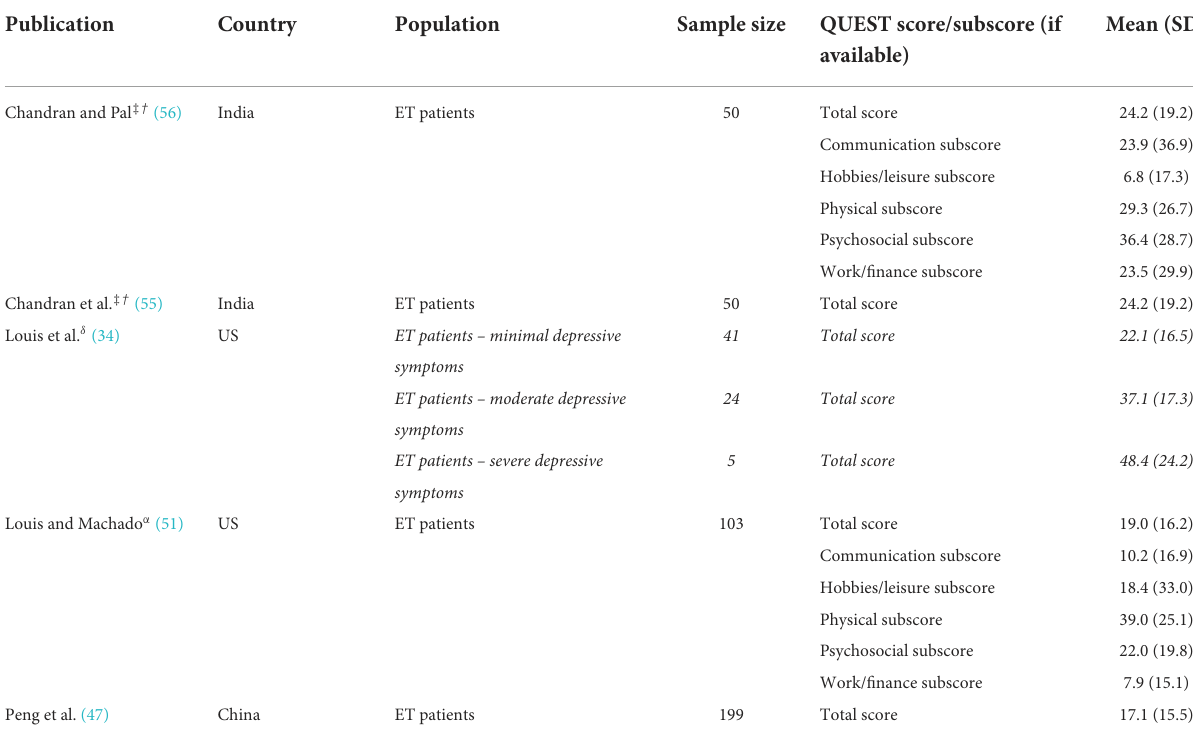
TABLE 4 Mean Quality of Life in Essential Tremor Questionnaire